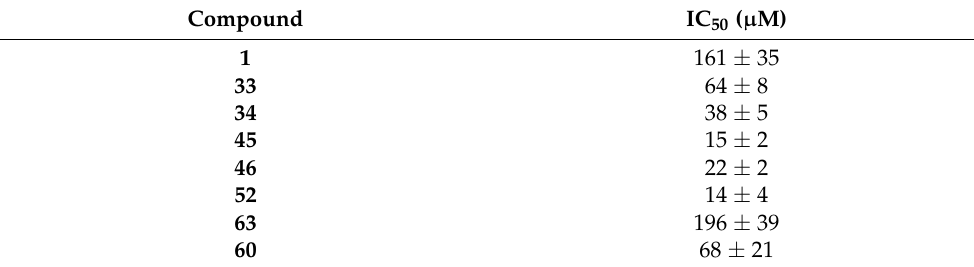
Table 3. Inhibitory activity on SARS-CoV-2 M pro enzyme activity.